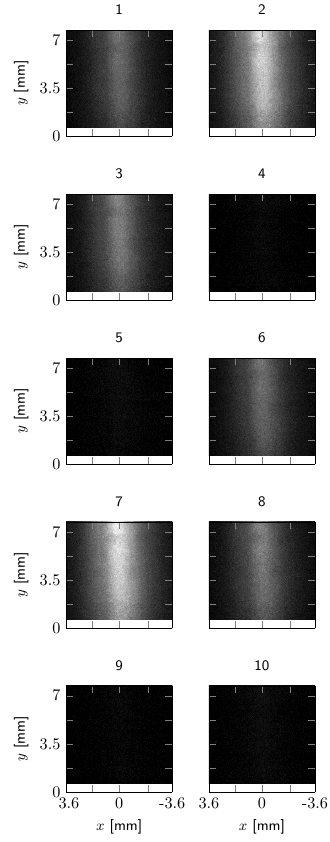
Figure 4. Sequence of 10 subsequent raw pictures, i.e. one modula- tion period according to f m = 100kHz. The light intensity is mod- ulated according to the modulation laser frequency (see Fig. 2).